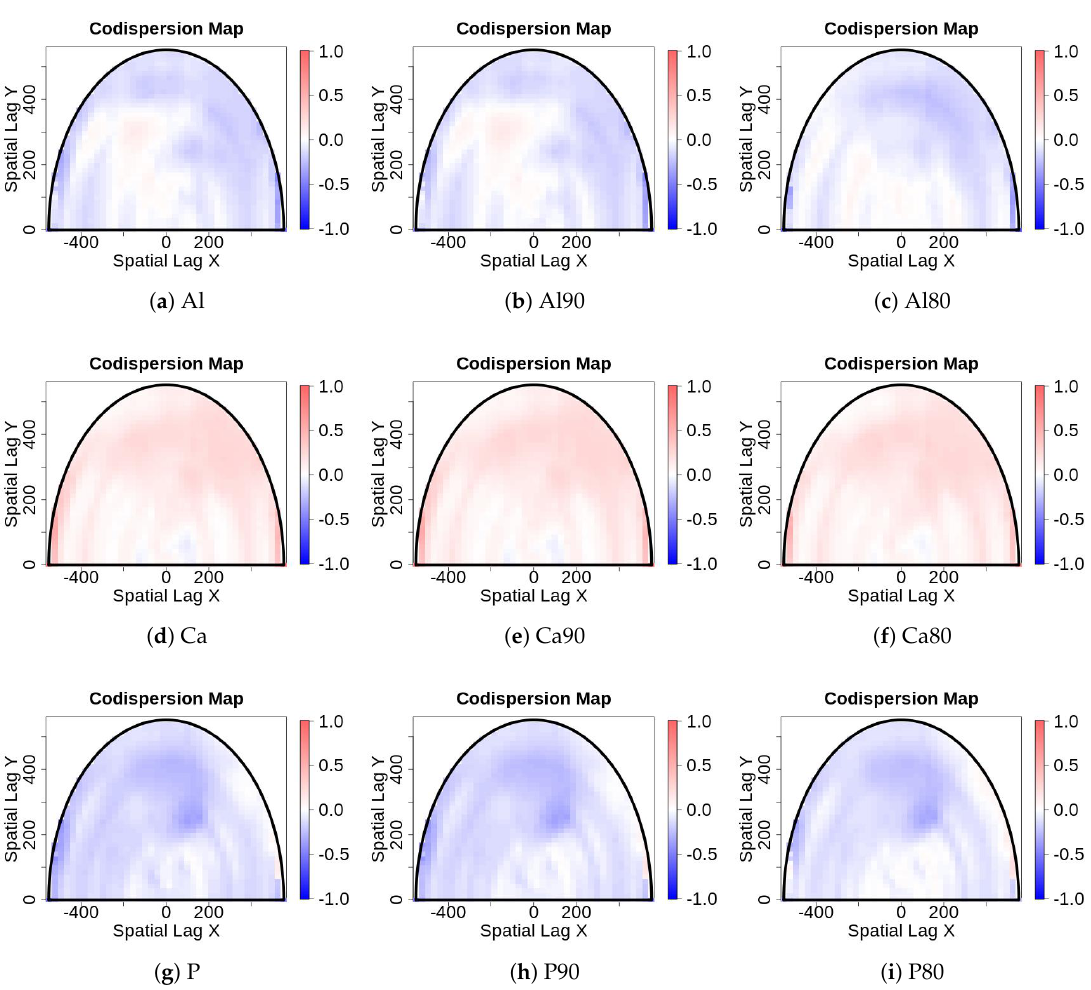
Figure 12. Codispersion between species P. armata and soil chemistry variables; (Al ( a – c ); Ca ( d – f ) and P ( g – i )). Soils data were unthinned ( a , d , g ), thinned 10% ( b , e , h ), or thinned 20% ( c , f , i